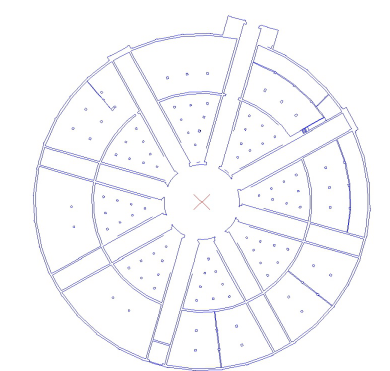
Figure 6. Plan of the ground floor at an elevation of 4,80 m.